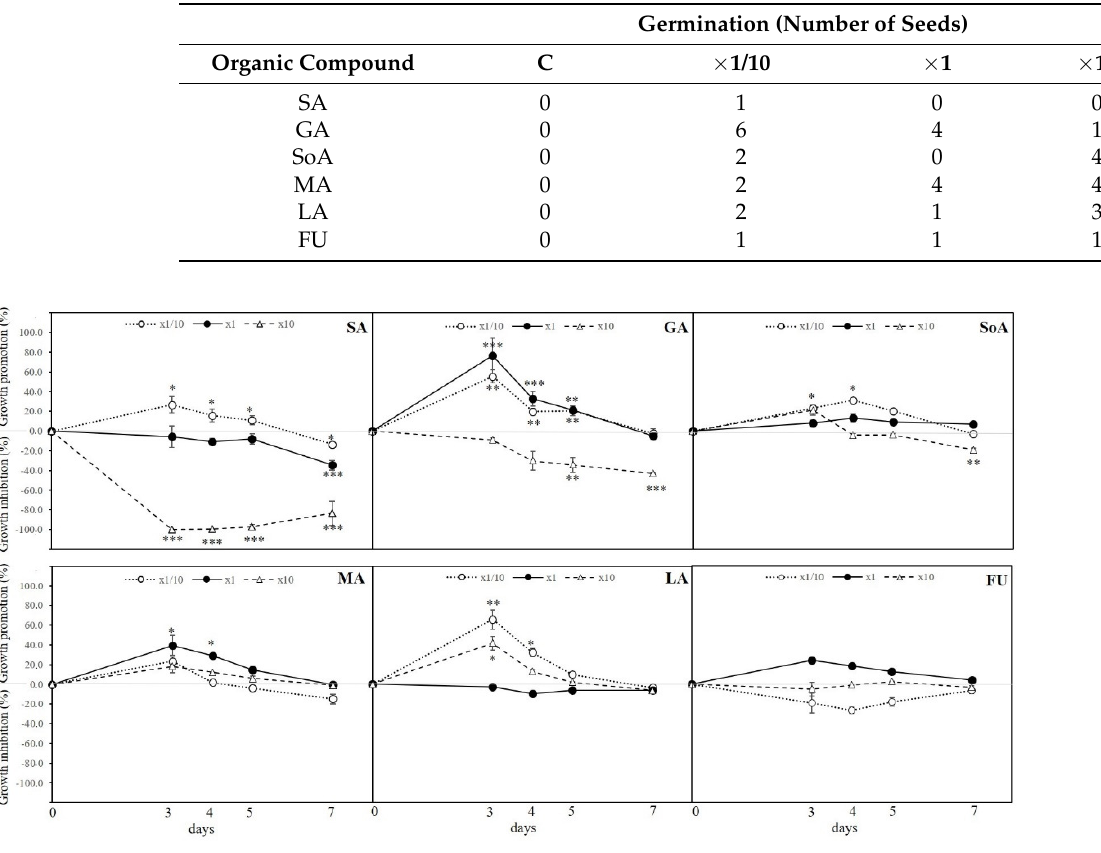
Figure 1. Growth promotion (+%) or growth inhibition ( − %) root seedlings at day 3, 4, 5, and 7 after organic compounds (salicylic acid (SA), gallic acid (GA), sodium alginate (SoA), mannitol (MA), laminarin (LA), and fucose (FU)) application at three concentrations (×1/10; ×1 and ×10) with respect to the untreated control. Data are means ± SE ( n = 3). *, **, and *** denote significant differences with respect to the control, according the LSD test at α = 0.05, 0.01, and 0.001, respectively. Table 2. Seeds germinated at day 2 after organic compounds (salicylic acid (SA), gallic acid (GA), sodium alginate (SoA), mannitol (MA), laminarin (LA), and fucose (FU)) application at three con-